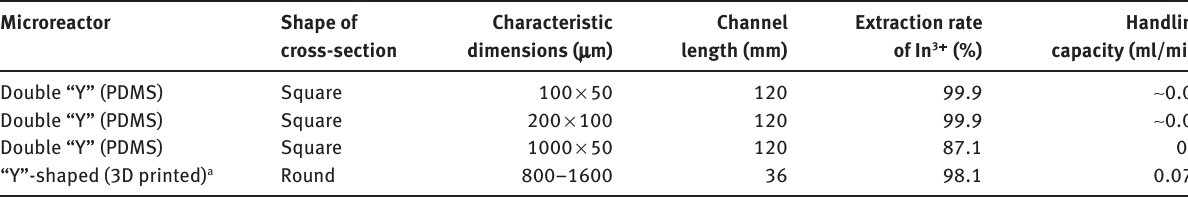
“Y”-shaped (3D printed)